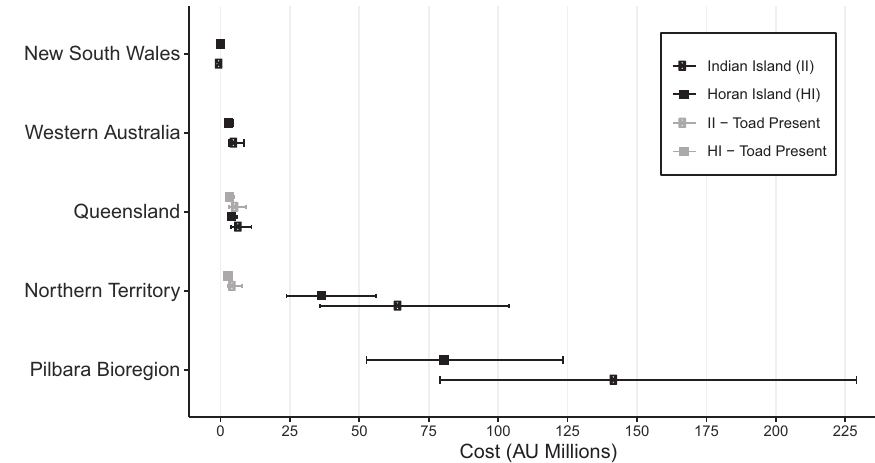
Figure 2. Distribution of the benefit of cane toad quarantine across different jurisdictions within Aus- tralia. Toad present distributions denote areas where toads are known to occur and represent the cost to remove toads. No islands in either New South Wales, Western Australia or the Pilbara Bioregion have confirmed toad